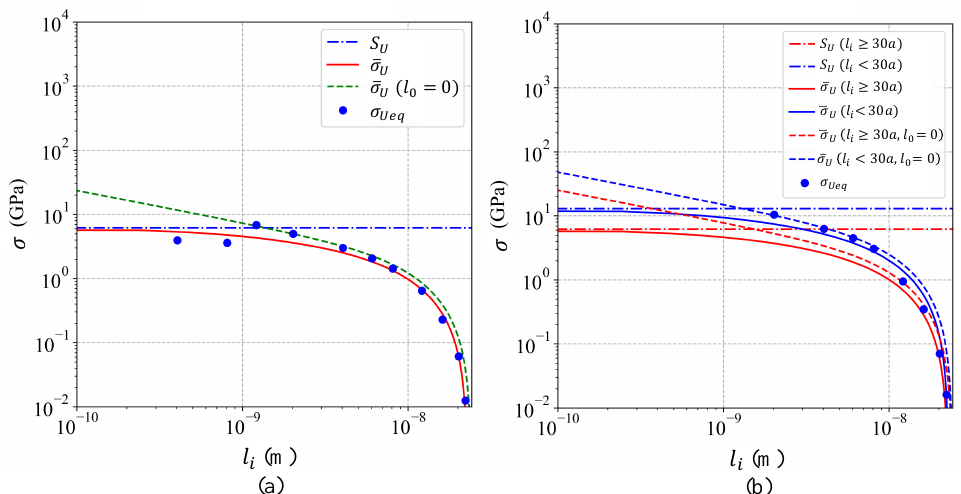
Figure 7. Model based on the EPFM parameter CTOD ( a ) for single-crystals Al and ( b ) for bi-crystals